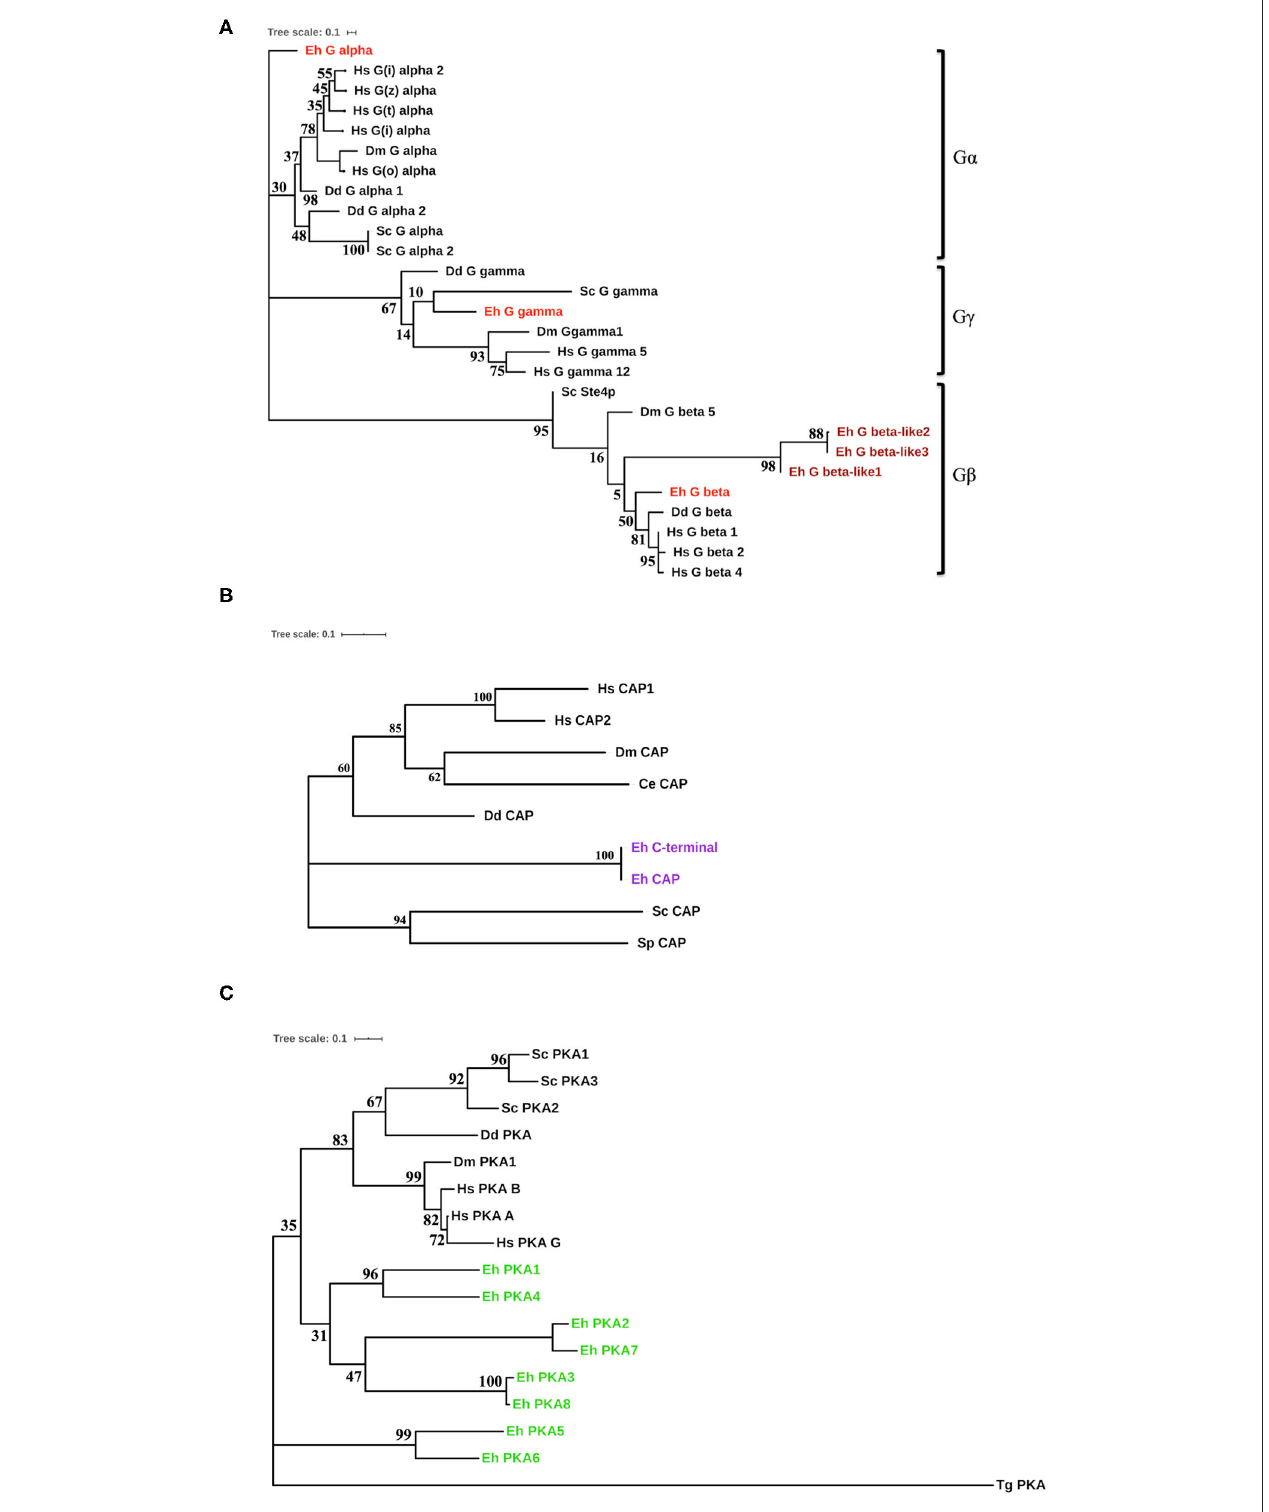
FIGURE 2 | Phylogenetic analysis of the cAMP pathway components from E. histolytica . (A) Phylogenetic analysis of the G-proteins. Three G-proteins were identified in E. histolytica (Eh): G α (G alpha), G β (G beta), and G γ (G gamma). The sequences of these putative proteins were analyzed phylogenetically with G-proteins from